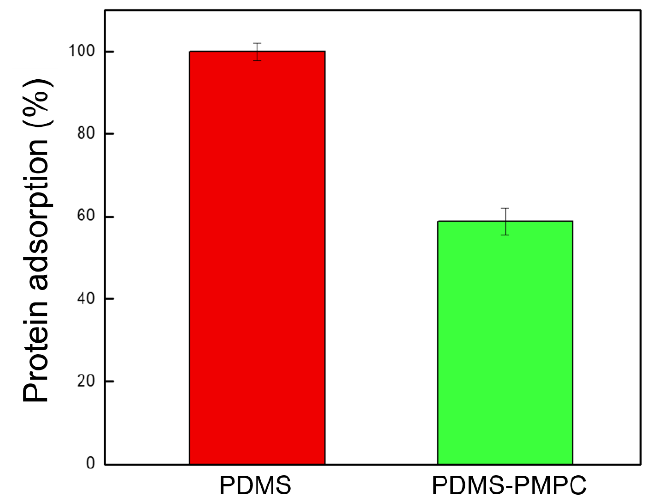
Figure 11. The anti-fouling capability of proteins (human serum albumin, HSA) on the pristine PDMS and PDMS-PMPC substrates ( n = 3).